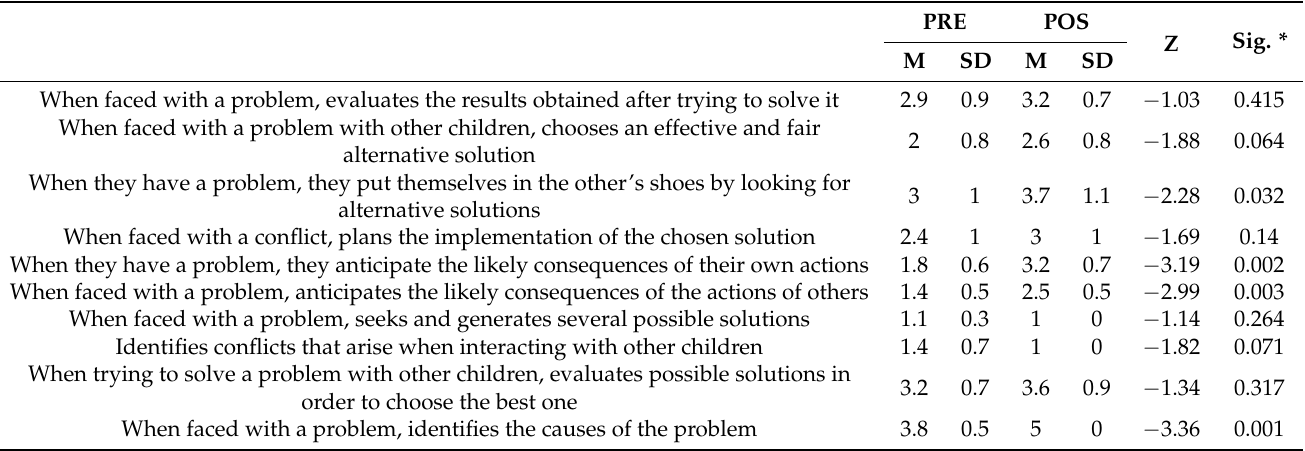
Table 5. Interpersonal problem-solving